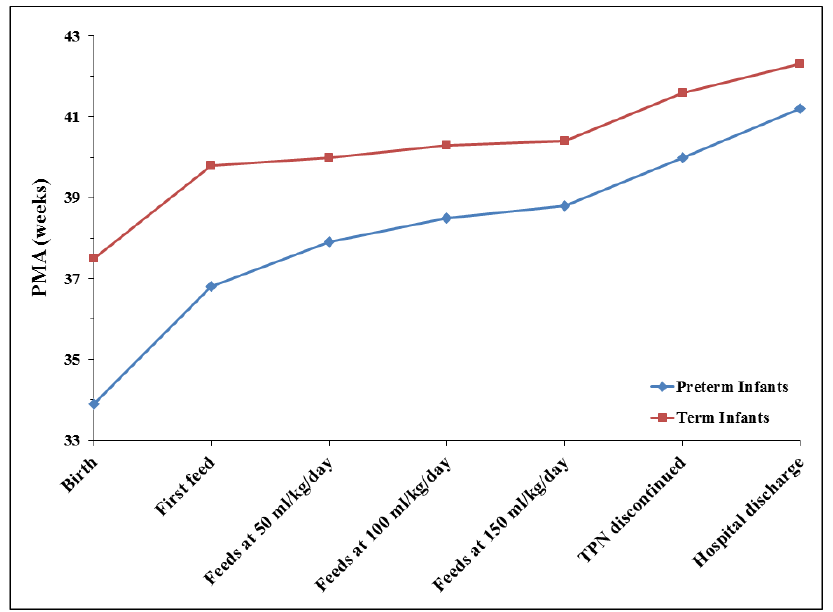
Figure 1: Median postmenstrual age (in weeks) of feeding achievements for term and preterm infants with gastroschisis.